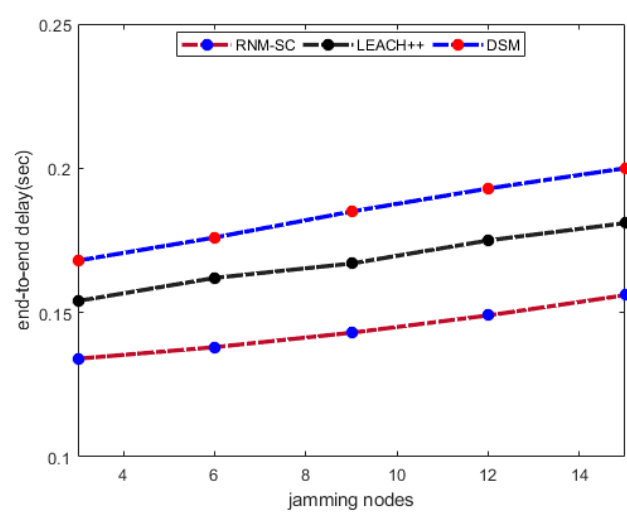
Figure 5. Packet drop ratio and jamming nodes.